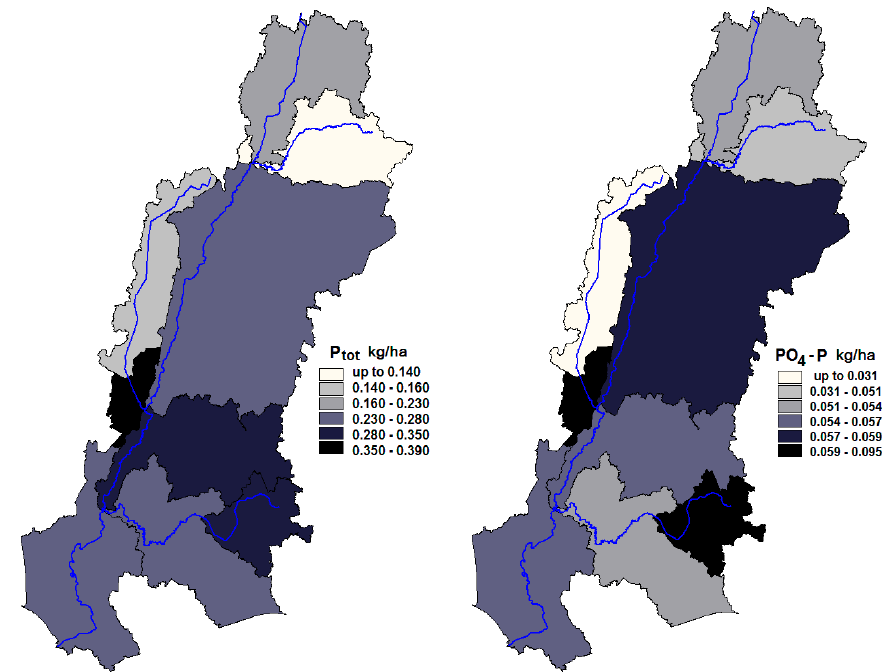
Figure 6. The share of PO 4 -P coming via tile drainage systems (right image) to the average annual amount of P-tot entering the Akmena-Dan ė River (left image) from each sub-catchment (SWAT model simulations).